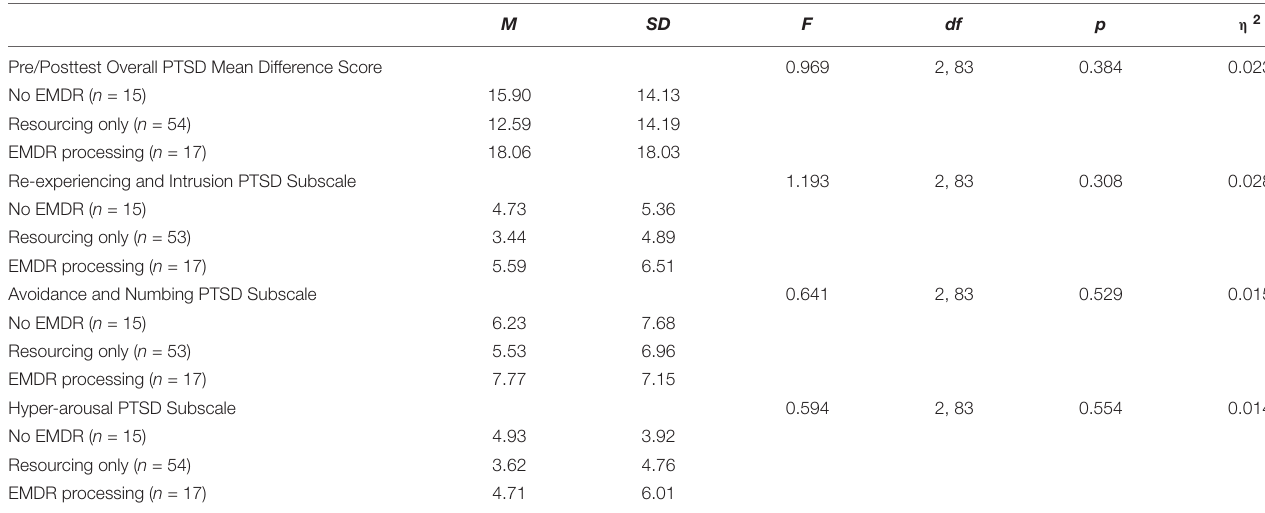
TABLE 2 | Results of the ANOVAs for Treatment Effectiveness by EMDR resource processing.